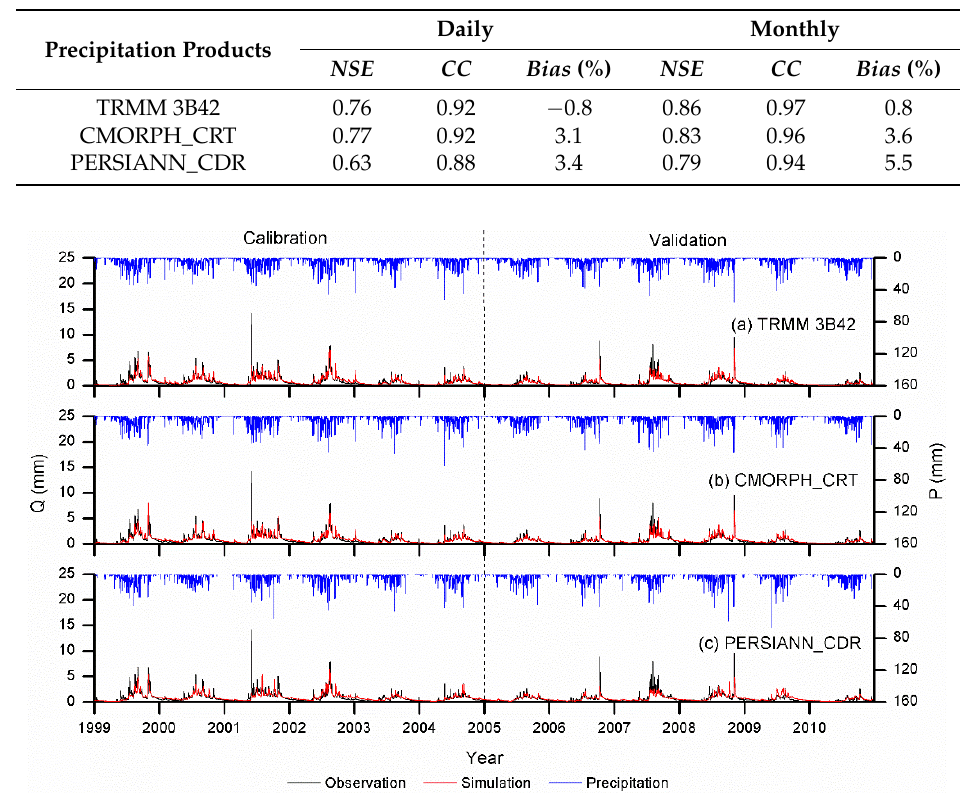
Figure 9. Simulated (red) and observed (black) daily streamflow under Scenario II from: ( a ) TRMM 3B42; ( b ) CMORPH_CRT; and ( c ) PERSIANN_CDR. Blue lines show precipitation data.